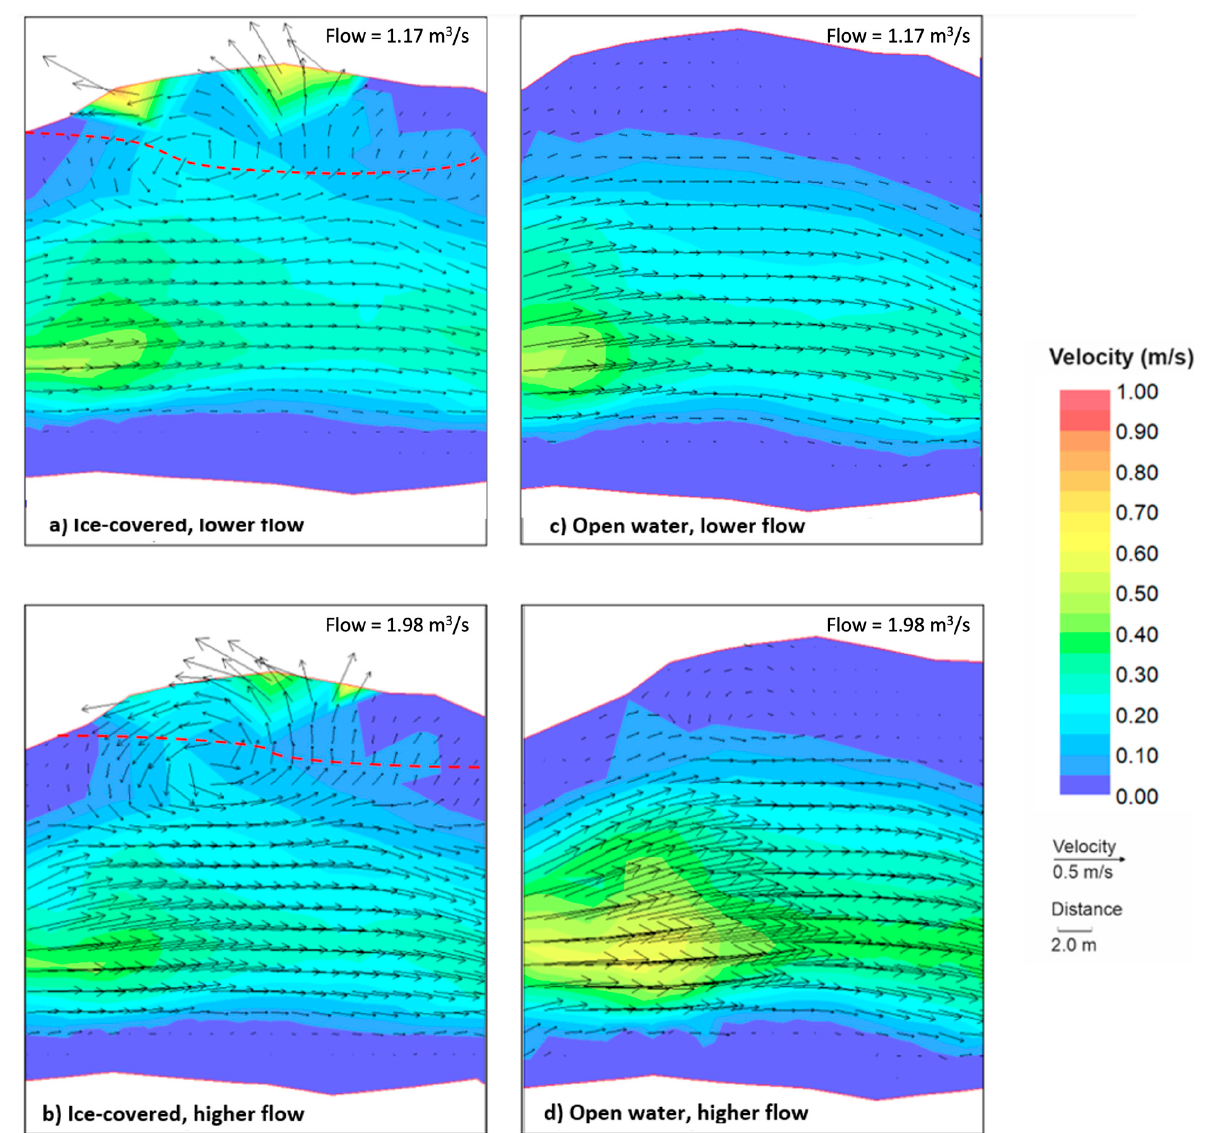
Figure 6. Depth-averaged velocity magnitude and directions within the pool under ( a ) lower flow, ice-covered conditions; ( b ) lower flow, open-water conditions; ( c ) higher flow, ice-covered condi- tions; and ( d ) higher flow, open-water conditions. Flow directions are indicated at 1 m intervals using vector arrows (if they were plotted at the mesh resolution of 0.1 m intervals it would be diffi- cult to visualize). Ice extent along the left bank is delineated by dashed line in ( a , c ). Prepared in River2D.